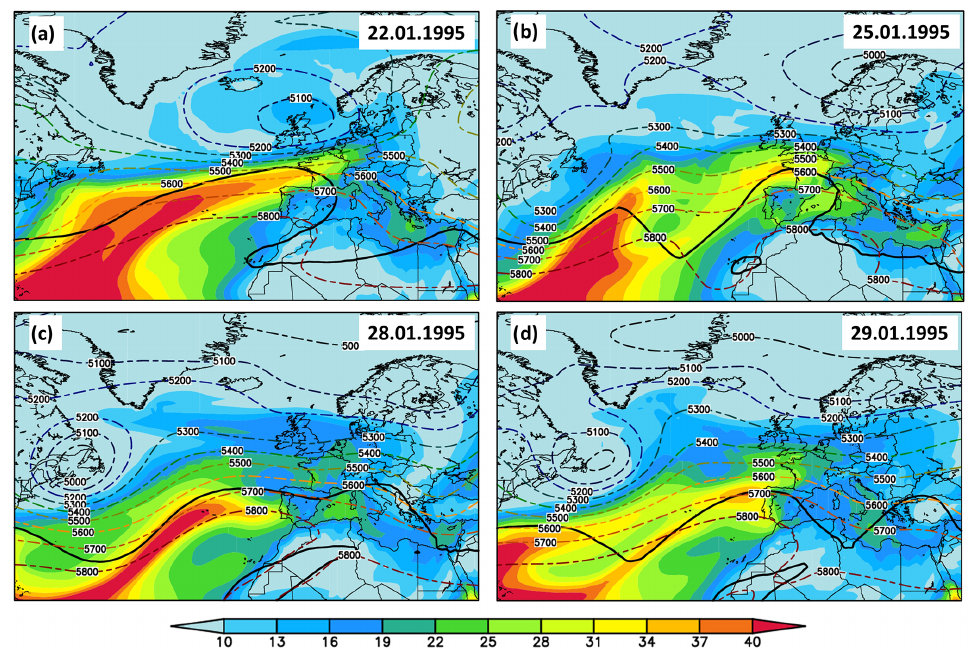
Figure 10. Daily integrated water vapor (IWV; shading) and daily geopotential height at 500hPa (Z500; contour lines) for (a) 22 Jan- uary 1995, (b) 25 January 1995, (c) 28 January 1995 and (d) 29 January 1995. The thick black line in panels (a) – (d) indicates the 2PV contour at 330K. Units: IWV (kgm − 2 ) and Z500 (m). Table 3. Monthly values of the North Atlantic Oscillation (NAO) index (second column), days with anticyclonic Rossby wave breaking (ARWB; third column) and the type of circulation patterns (Großwetterlage – GWL; fourth column) active during the days prior to each of the 10 extreme flood peaks at the Köln gauging station. Note: cyclonic west wind – WZ; southern west wind – WS; northwest cyclonic – NWZ; anticyclonic west wind – WA; western European trough – WW. Monthly ARWB GWL